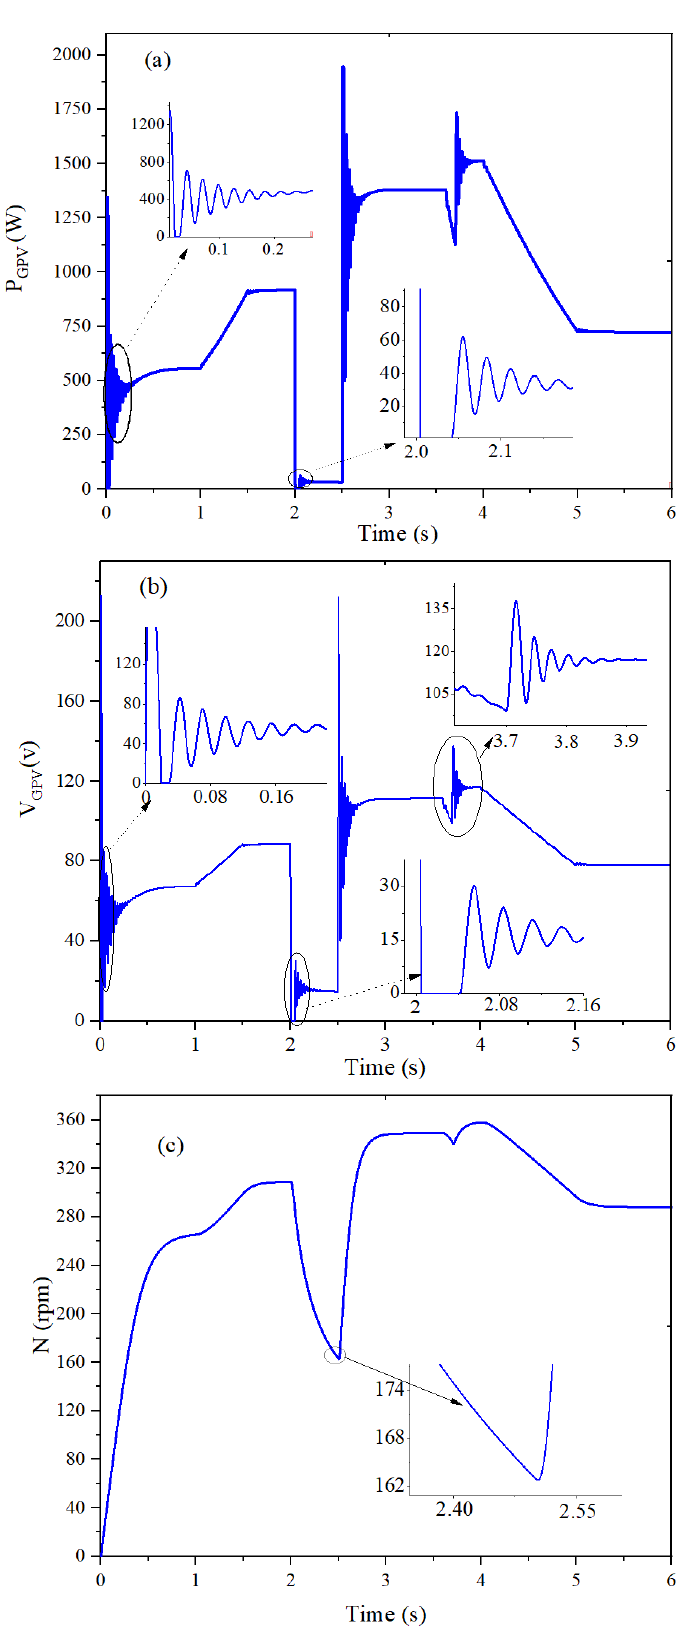
Figure 12. Simulation results for direct coupling. ( a ) Instantaneous power extracted from the GPV, ( b ) terminal voltage at the pump motor, ( c ) rotation speed of the pump motor.